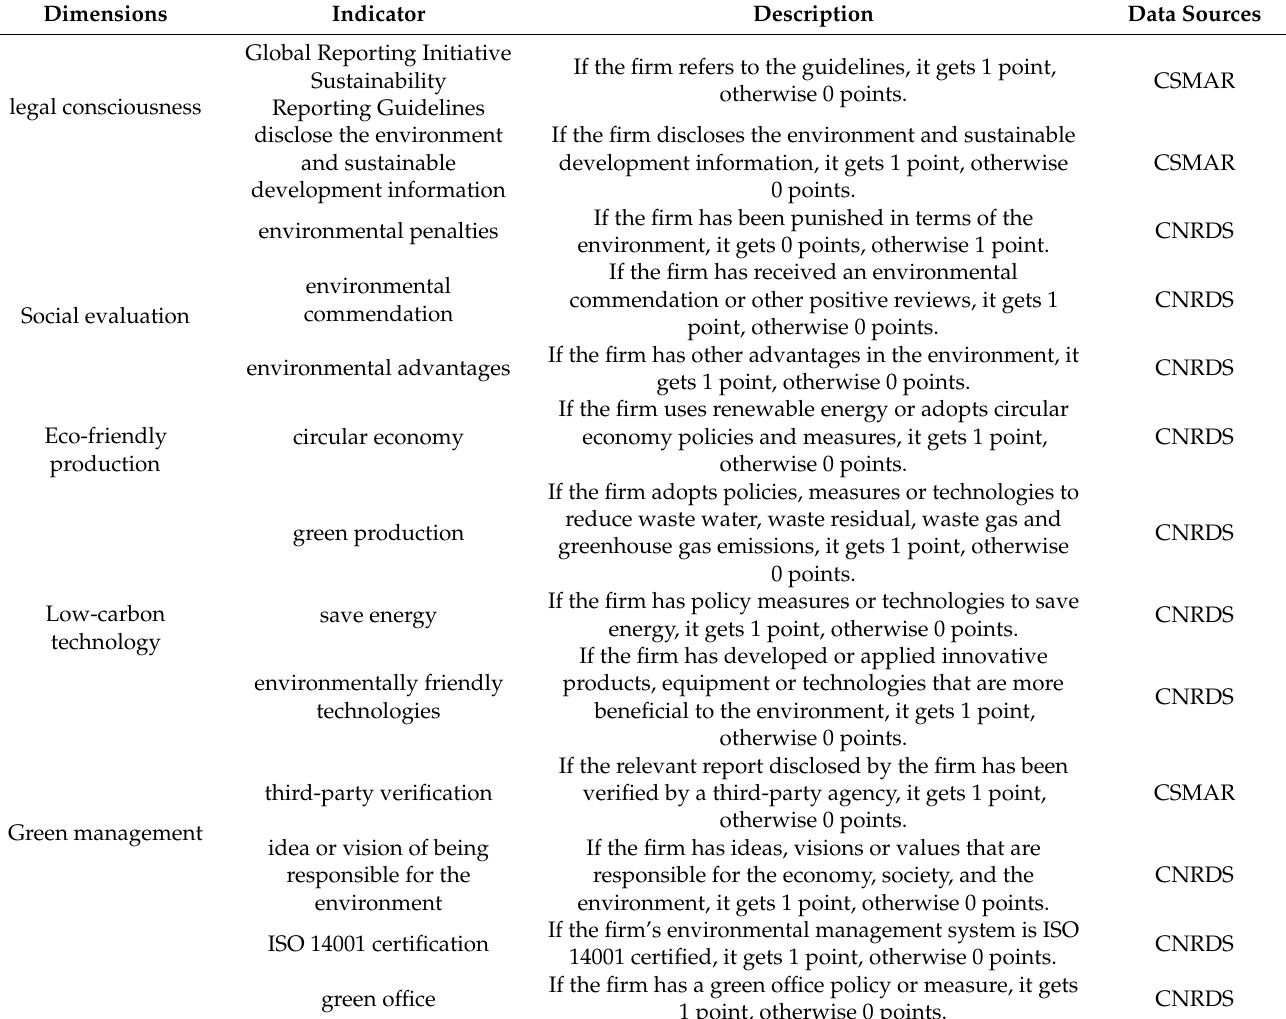
Table 2. Corporate Environmental responsibility